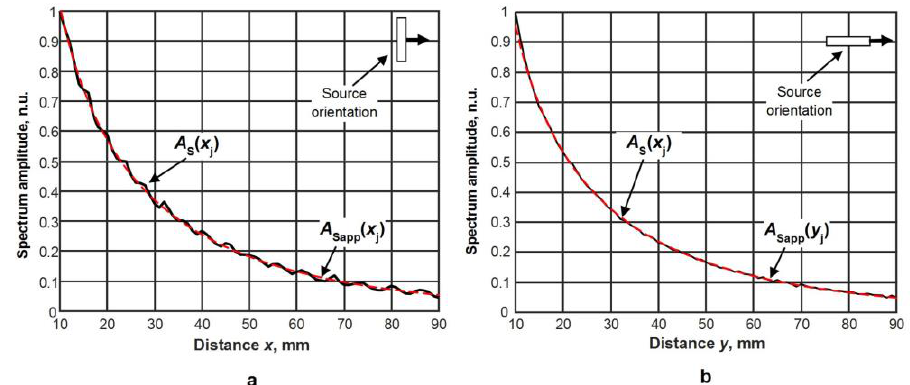
( , ) A x y of the spectra of the measured S j i